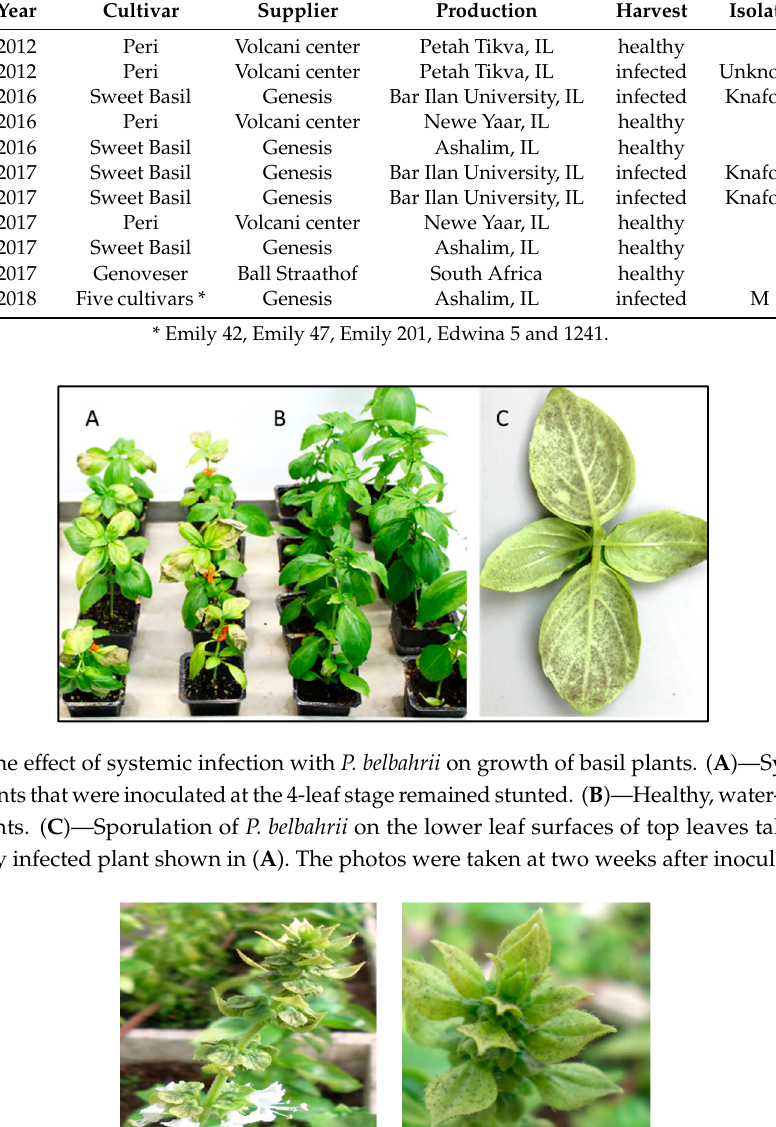
Table 2. The origin of basil seeds used in this study.